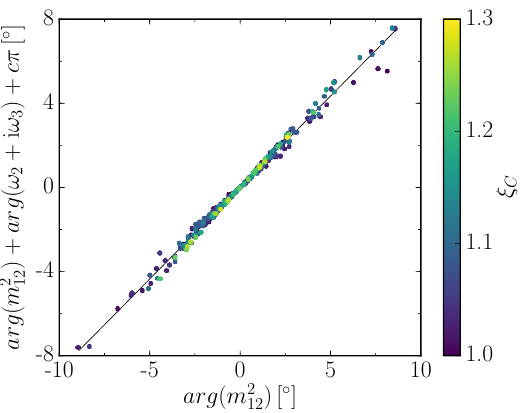
Figure 12 . Type II, H 1 = h : the total CP-violating angle at the critical temperature T c versus the CP-violating angle at T = 0. By adding c(cid:25) , c range 90 (cid:14) to 90 (cid:14) . The colour code indicates the size of (cid:24) c (cid:0)